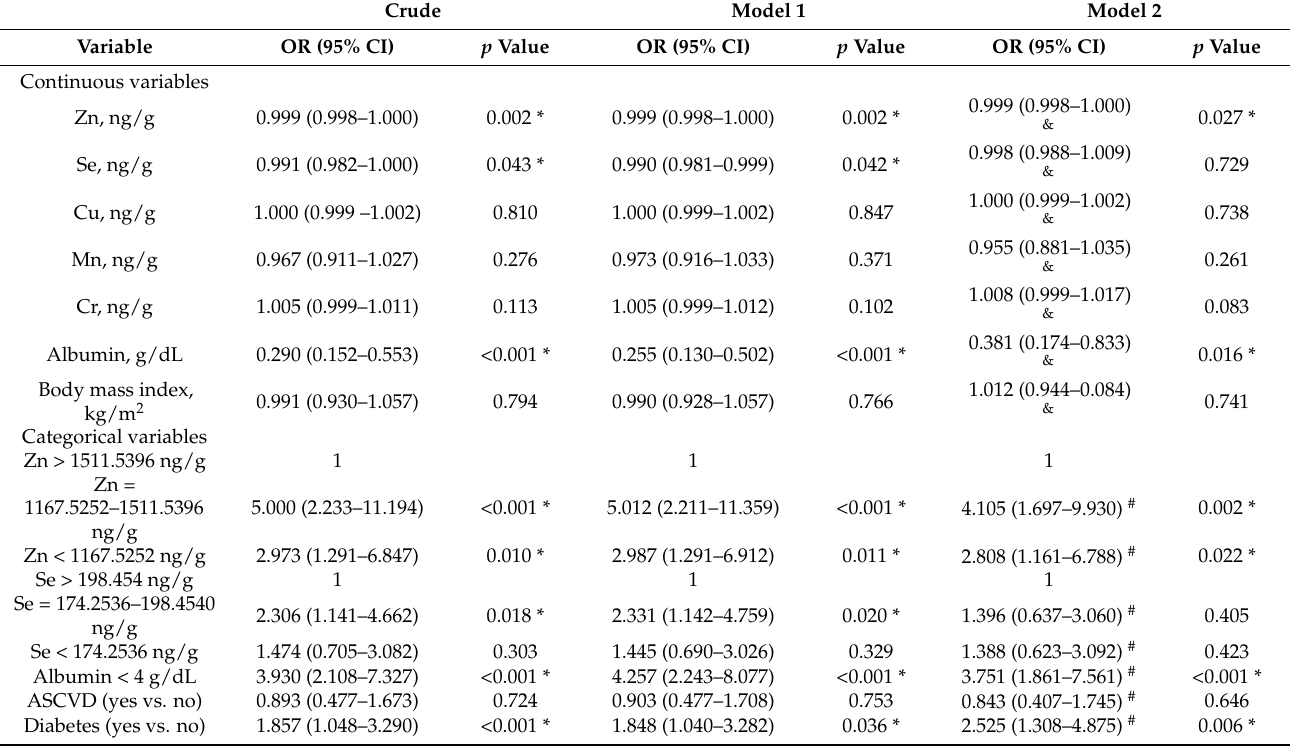
Table 4. OR of variables associated with ESRD needing dialysis.